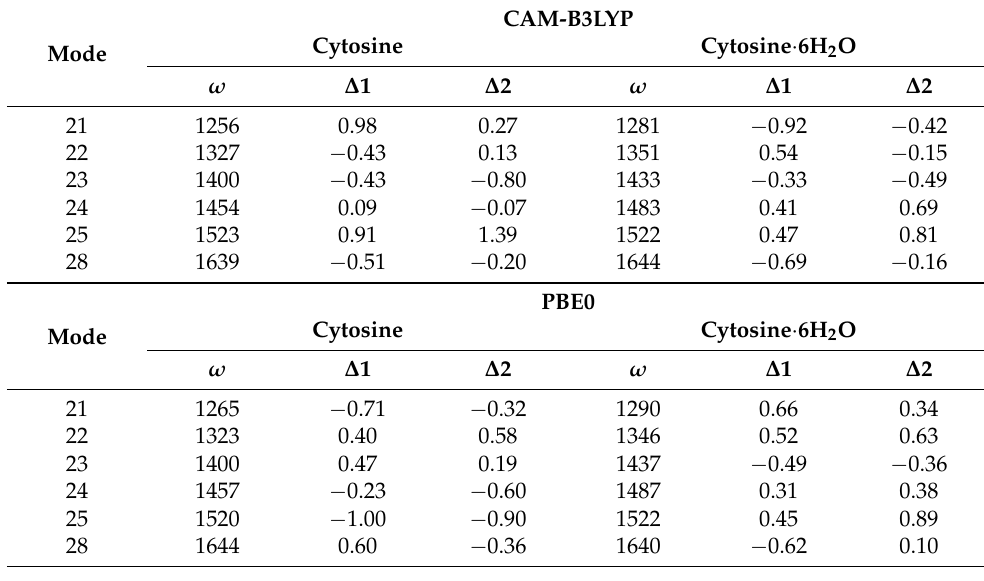
Figure 5. Schematic representation of the most relevant vRR-active vibrational modes of cytosine in the high-frequency range, and cytosine ¨ 6H 2 O, removing the components of the 6H 2 O from the Hessian, calculated by CAM-B3LYP and the 6-311G+(d,p) basis sets in water. Table 3. Analysis of the modes responsible for the strongest vRR fundamental bands in resonance with the S 1 electronic state. Frequencies ( ω ) scaled by 0.96 are in wavenumbers, whereas ∆ 1 and ∆ 2 are the dimensionless shifts of the equilibrium geometry in S 1 and S 2 ,